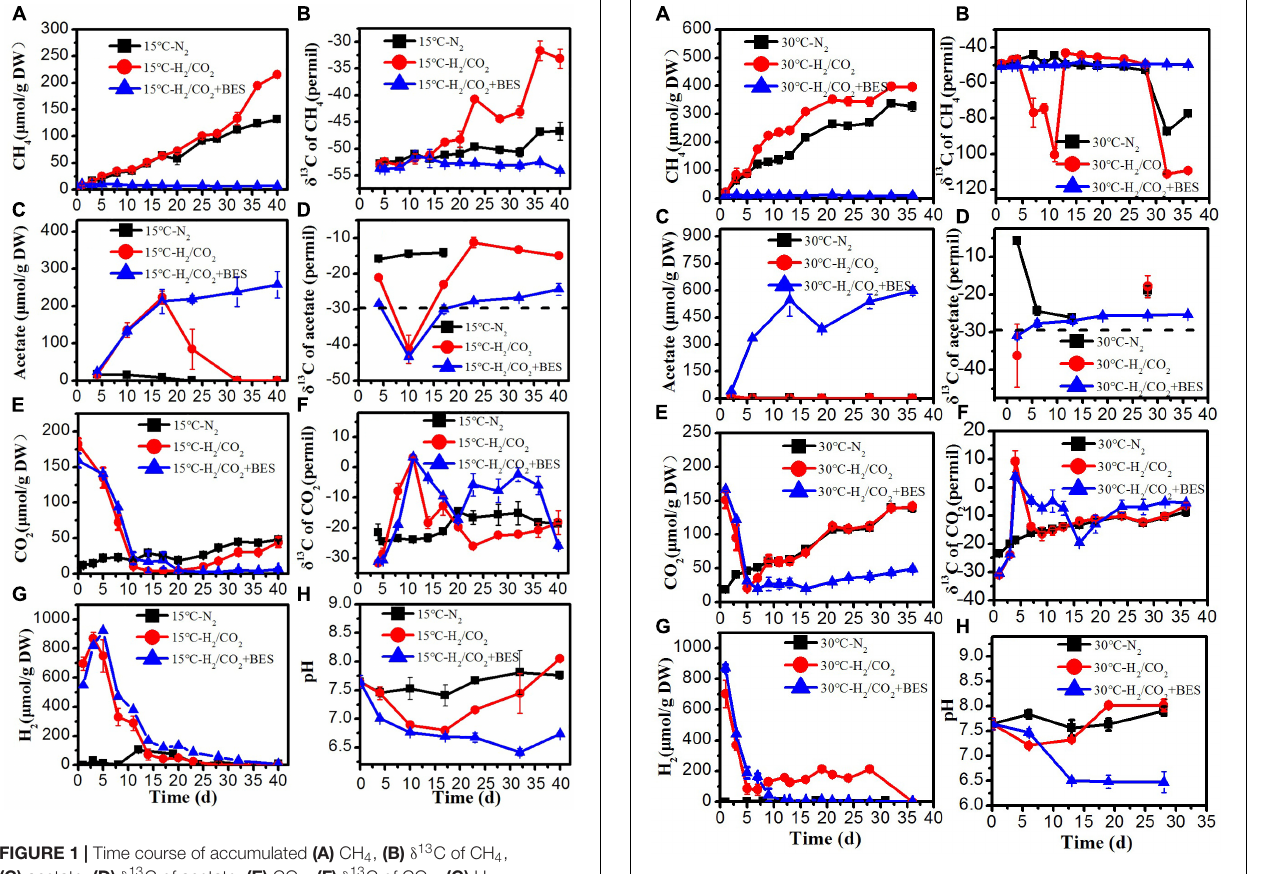
FIGURE 2 | Time course of accumulated (A) CH 4 , (B) δ 13 C of CH 4 , (C) acetate, (D) δ 13 C of acetate, (E) CO 2 , (F) δ 13 C of CO 2 , (G) H 2 concentration, and (H) pH during the treatment of sewage sludge at 30 ◦ C, BES as an inhibiter of methanogenesis. The δ 13 C of the sludge organic